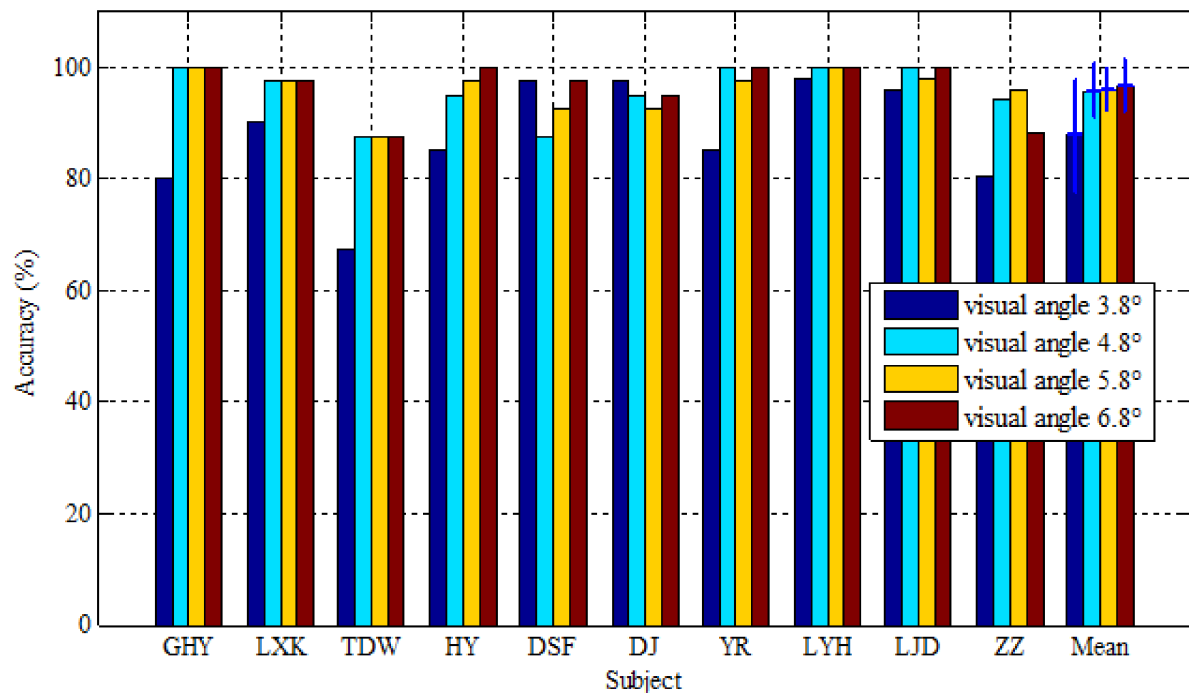
Fig 6. Classification accuracy of each subject and their average at four different proximities measured by center to center distance and denoted by visual angles 3.8°, 4.8°, 5.8° and 6.8°. The error bars represent standard deviation.